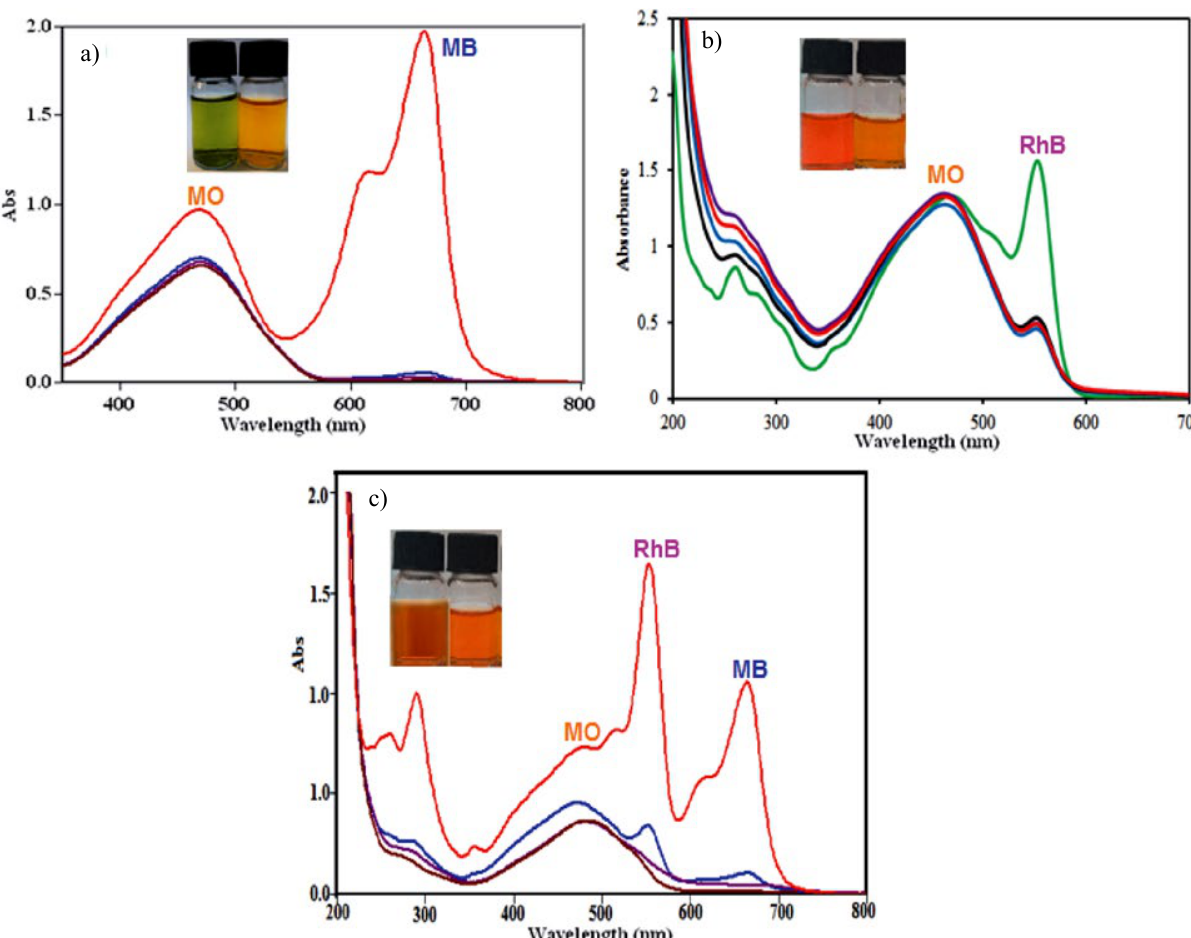
Figure 12. Selective adsorption ability of Fe MB+RhB+MO. Conditions :